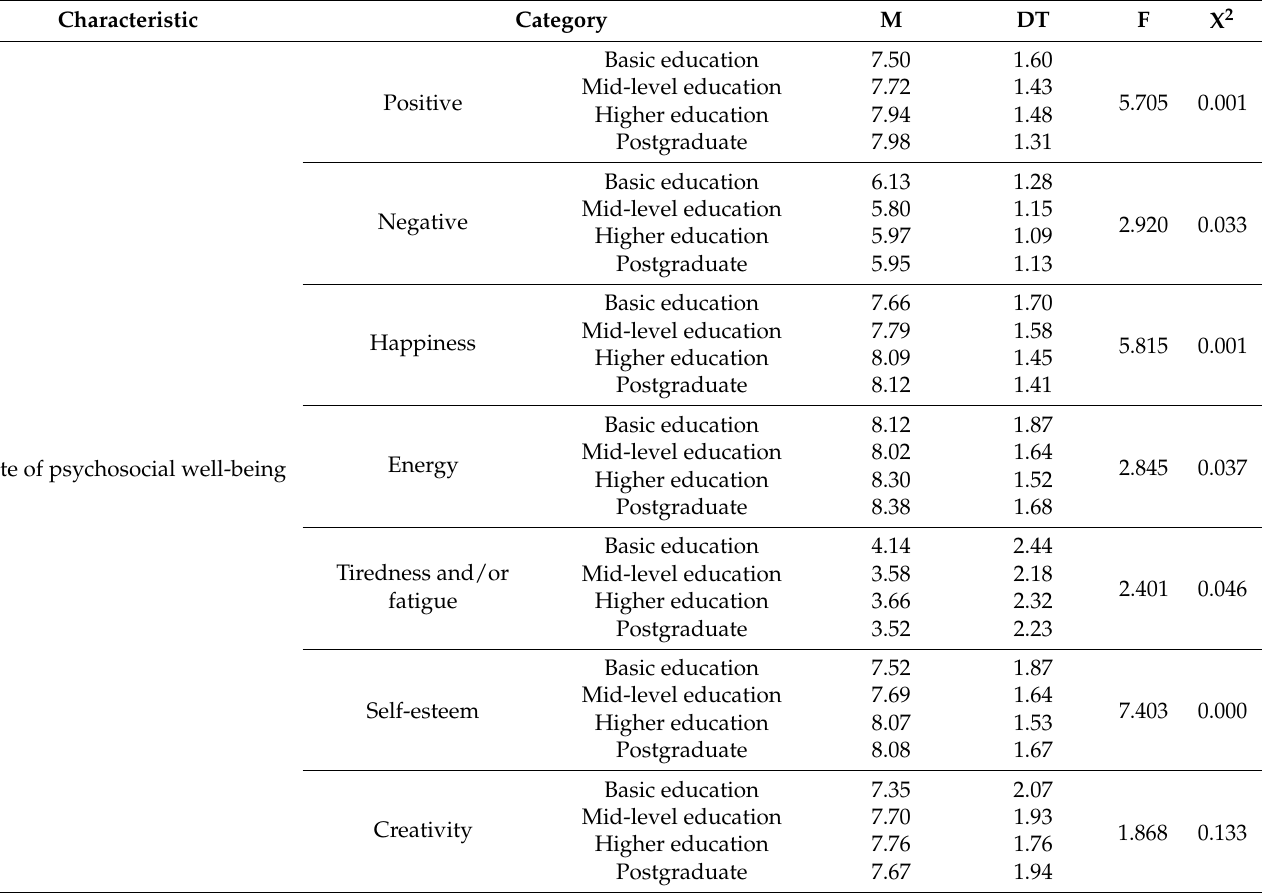
Table 9. State of psychosocial well-being according to the educational level of European parents. Characteristic